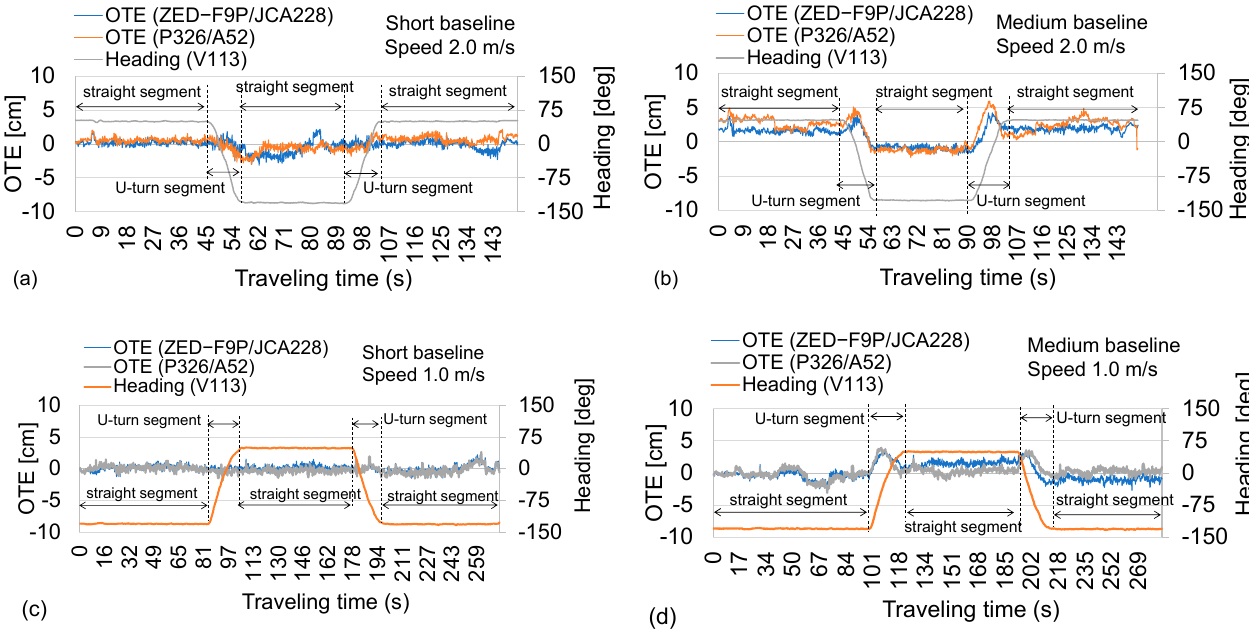
Figure 9. Sample data of OTE calculated from the dynamic positioning data of the manual driving ( a , b ) and autonomous driving tests ( c , d ).